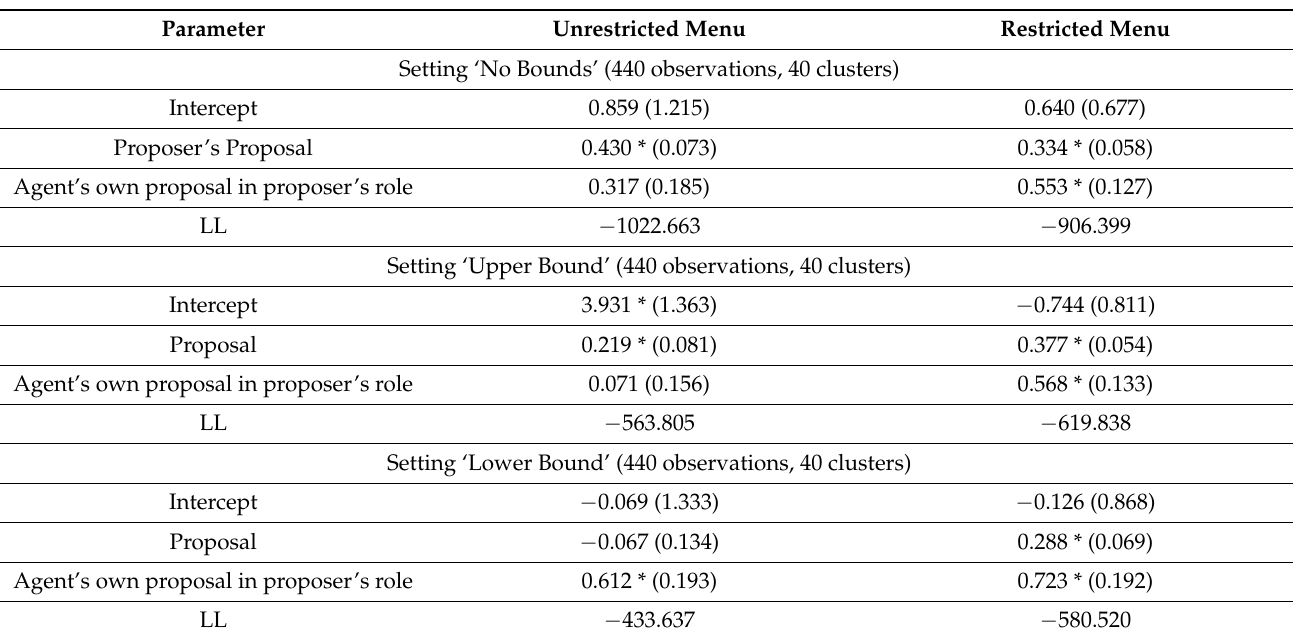
Table A1. Accounting for the agent’s own proposal when he is in proposer’s role, in addition to the partnered proposer’s proposal. Estimates for linear regression of agent’s response function for nonbinding setting proposal (where there are no limits), Upper Bound, and Lower Bound, and pooled settings. Right and left censoring was conducted via Tobit in Upper Bound and Lower Bound settings and in the pooled setting. Robust standard errors (N = 40) are reported in all